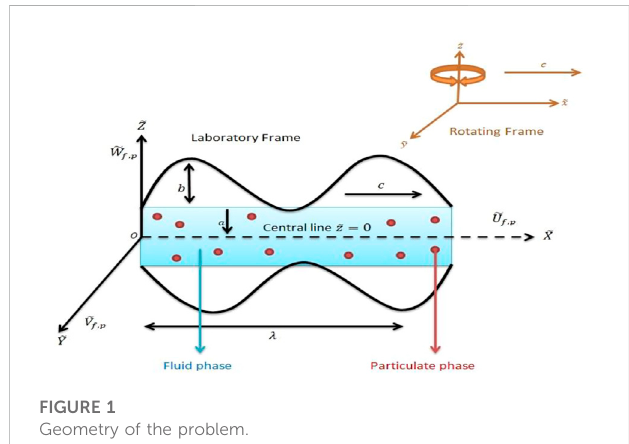
FIGURE 1 Geometry of the